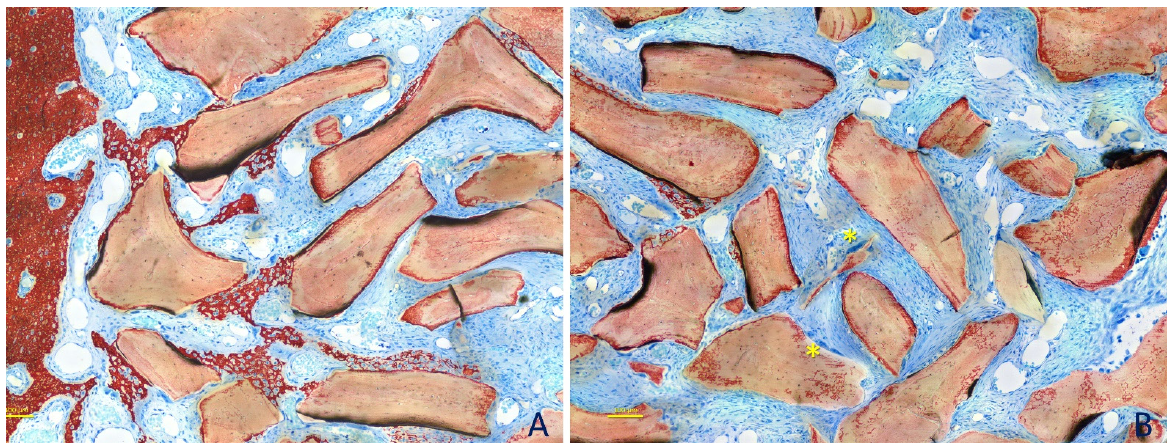
Figure 5. Photomicrographs of ground sections representing the healing after 2 weeks at small granules sites. ( A ) Newly formed bone was found close to the bone walls and lining on the surface of the DBBM. ( B ) A dense tissue rich in fibroblast- like cell was seen surrounding the DBBM particles. A loose tissue rich in vessels was interposed among particles. Some multicellular cells were visible (e.g., *). Original magnification ×200. Stevenel’s blue and alizarin red stain. Table 1. Tissue components within the augmented sinuses in the three periods of evaluation. Mean values (in bold) ± standard deviations; median in percentages. New Bone Marrow Spaces DBBM Dense Tissue Loose Tissue Vessels Other Tissues